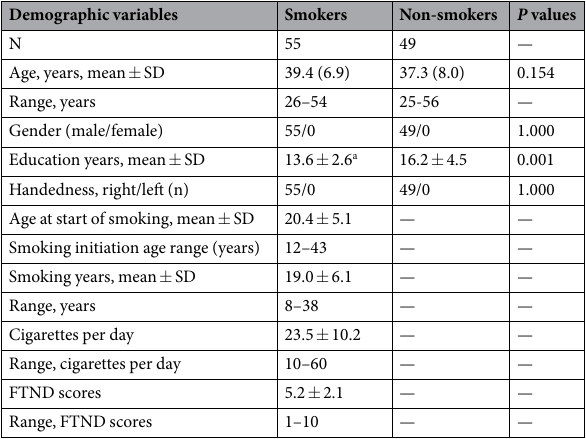
Table 1. Demographic characteristics and tobacco use parameters of smokers and non-smokers. a Significantly different from control group, p < 0.01. FTND Fagerström test for Nicotine Dependence. Two-sample two-tailed t tests were used for age and years of education comparisons between smokers and non-smokers. Chi-squared test was performed for gender and handedness comparison between smokers and